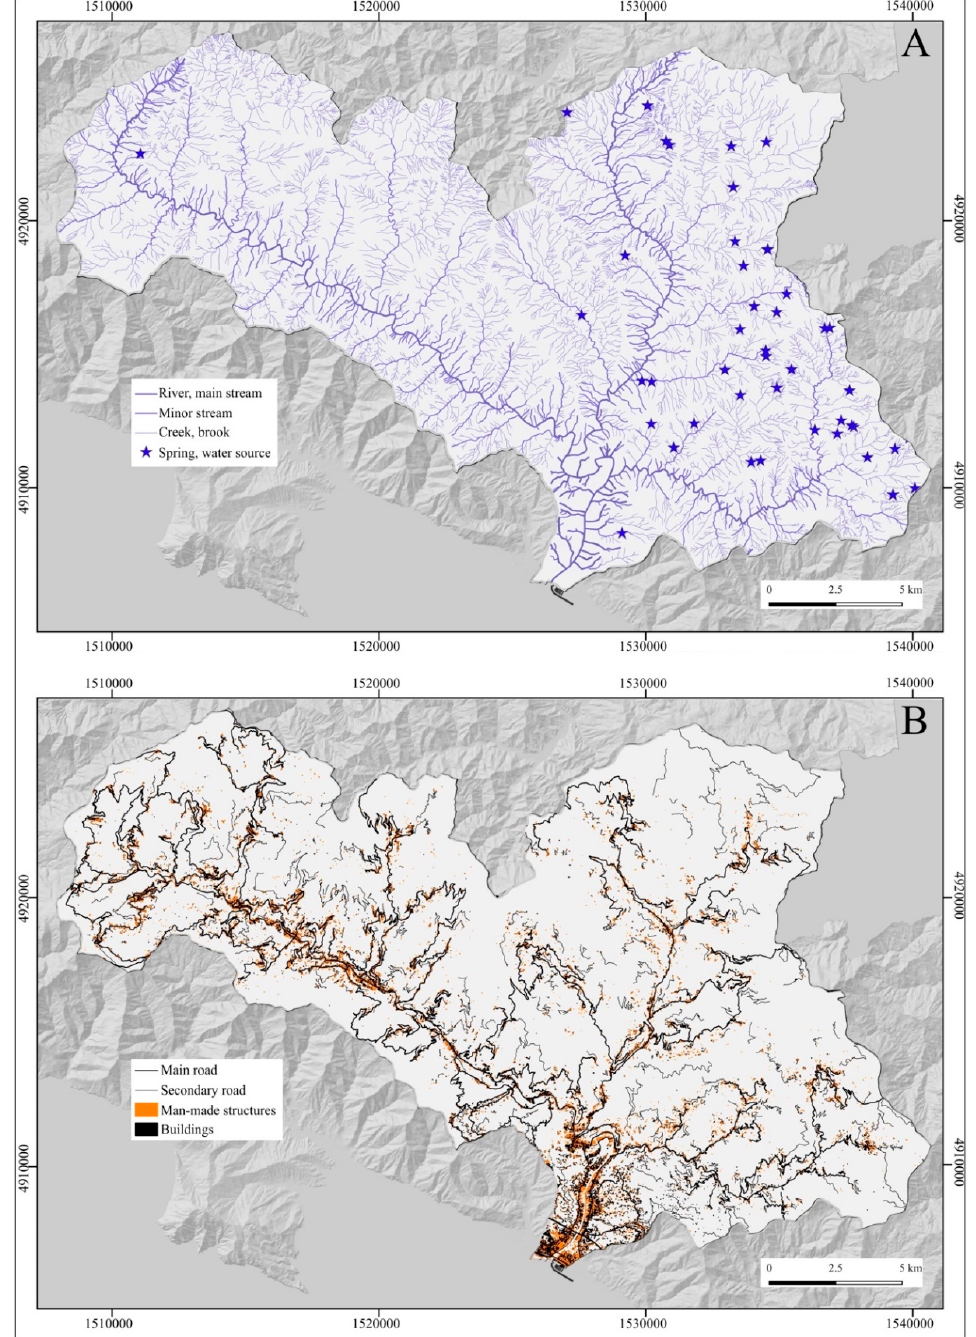
Figure 6. Thematic maps representative of the landslide predisposing factors: ( A ) drainage pattern; ( B ) anthropic elements (roads, buildings, retaining walls, artificial scarps, terraces and other man-made structures, etc.).